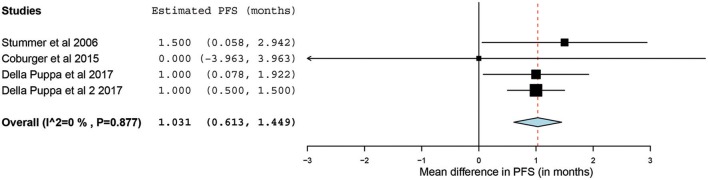
Forest plot graph representing the meta-analysis of mean difference in progression-free survival (95% confidence interval [CI]) among patients with primary high-grade glioma treated using 5-aminolevulinic acid–guided surgical resection vs. conventional microsurgical resection. Used with permission from Barrow Neurological Institute, Phoenix, Arizona.